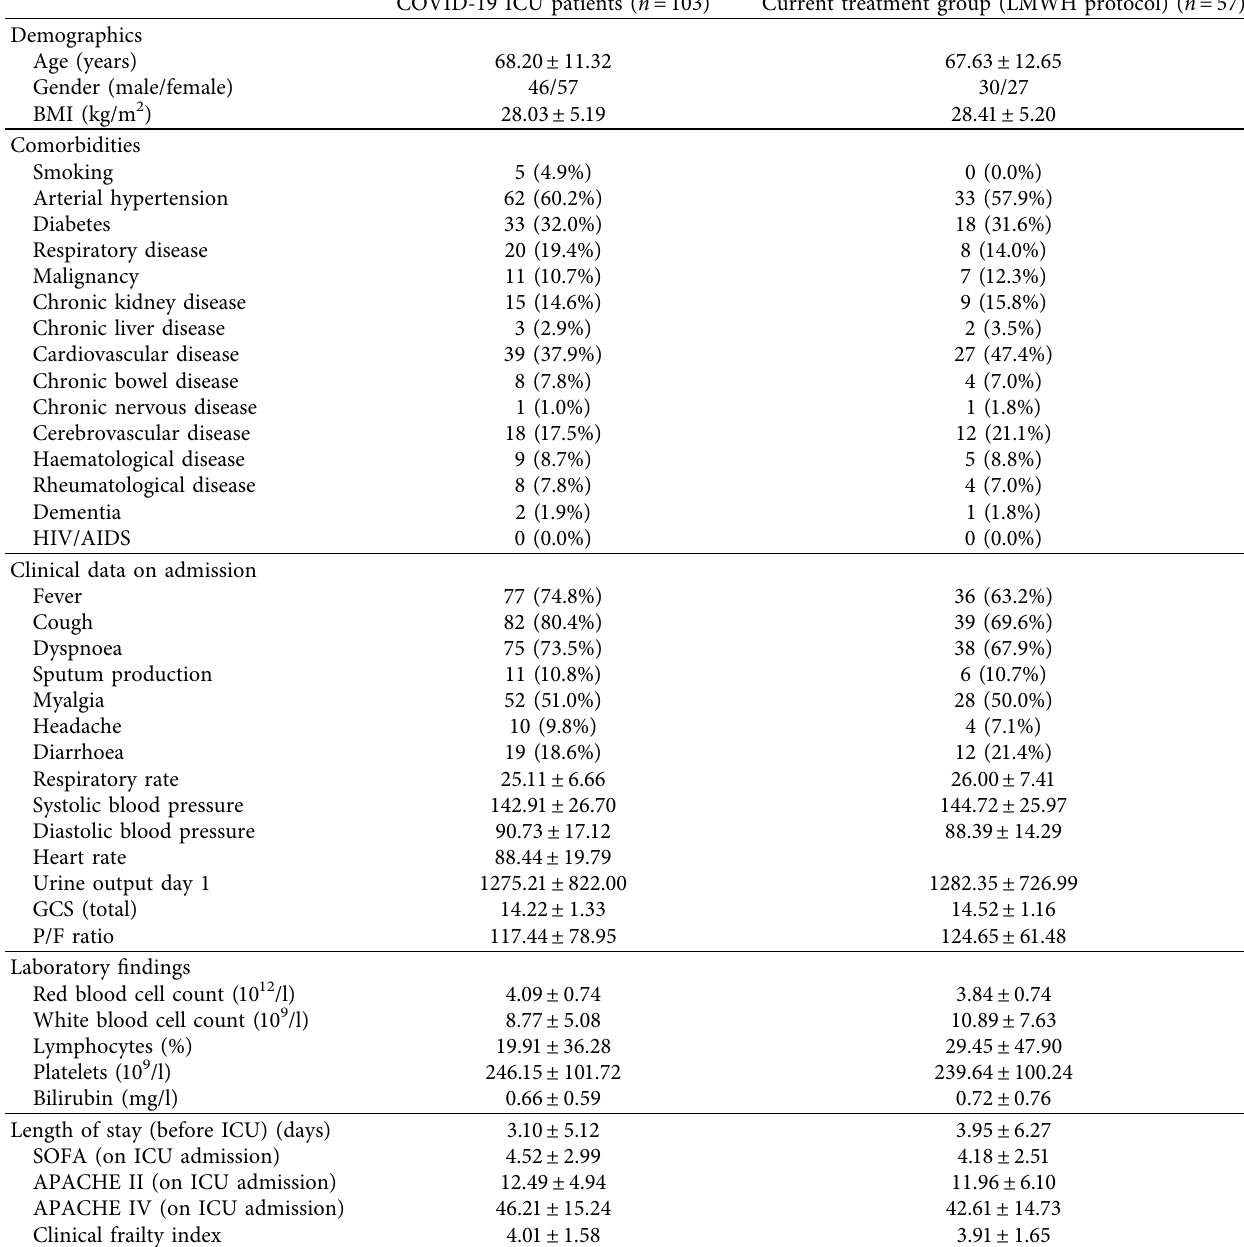
Table 1: Baseline